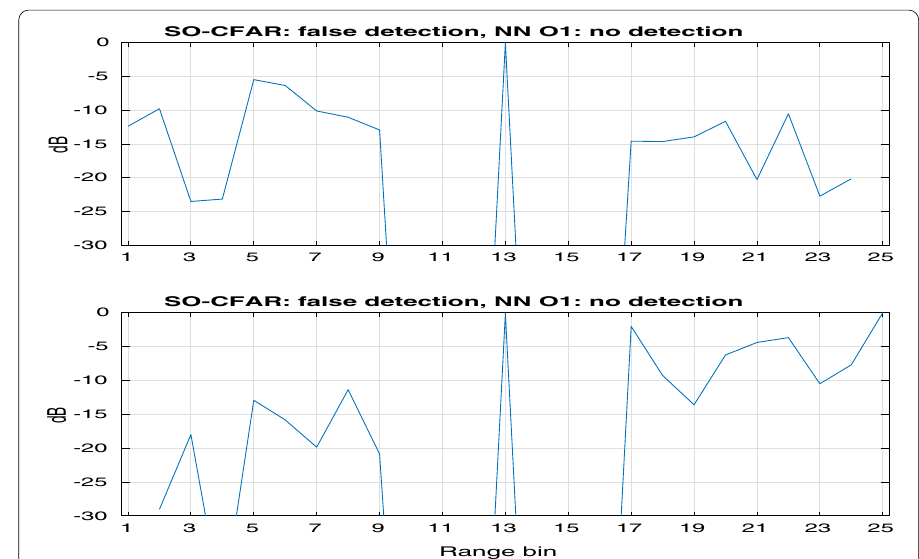
Fig. 13 Two sliding window examples with incorrect SO-CFAR detection but correct NN